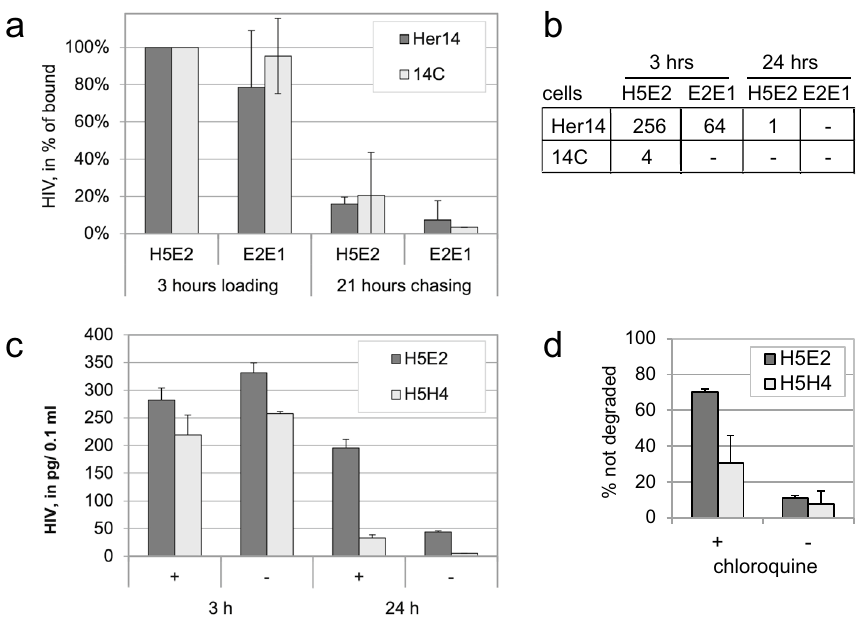
Figure 4. Specific binding of infective HIV particles/virions to EGFR expressing cells results in internalization and lysosomal degradation. ( a ) HIV bound to cells is internalized and degraded upon incubation . Pre-incubated HXB2 was incubated with Her14 and 14C cells (both expressing EGFR) for 3 h (loading), and non-bound virus washed away. Viral protein was determined directly (loading) and after 21 h, by measuring p24 in cell lysates by ELISA. n = 2, mean ± sd. ( b ) Trans-infectivity assay. Separately, after the indicated time points MT2 indicator cells were added to establish trans-infectivity of the bound HIV. Titre indicates the viral dilution at which syncytia are still formed. n = 2, identical results. ( c ) Chloroquine inhibits degradation of internalized HIV. Her14 cells were treated ( +) or not (-) with 100 µM chloroquine and incubated with virus for 3 h, in the presence of heparin Then washed and incubated for 24 h. HIV presence was determined by p24 ELISA. n = 2, representative experiment shown. ( d ) The graph indicates the percentage of HIV that is not degraded after 24 h as percentage of the input that is bound after 3 h. n = 2, mean ±